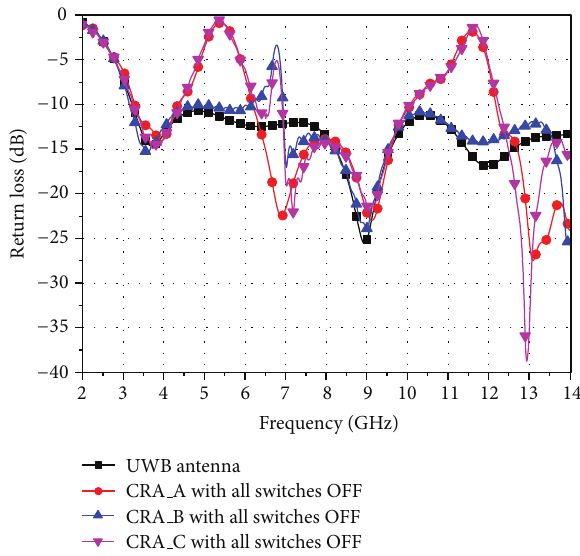
Figure 12: Comparisons of proposed cognitive radio antennas with all switches OFF.